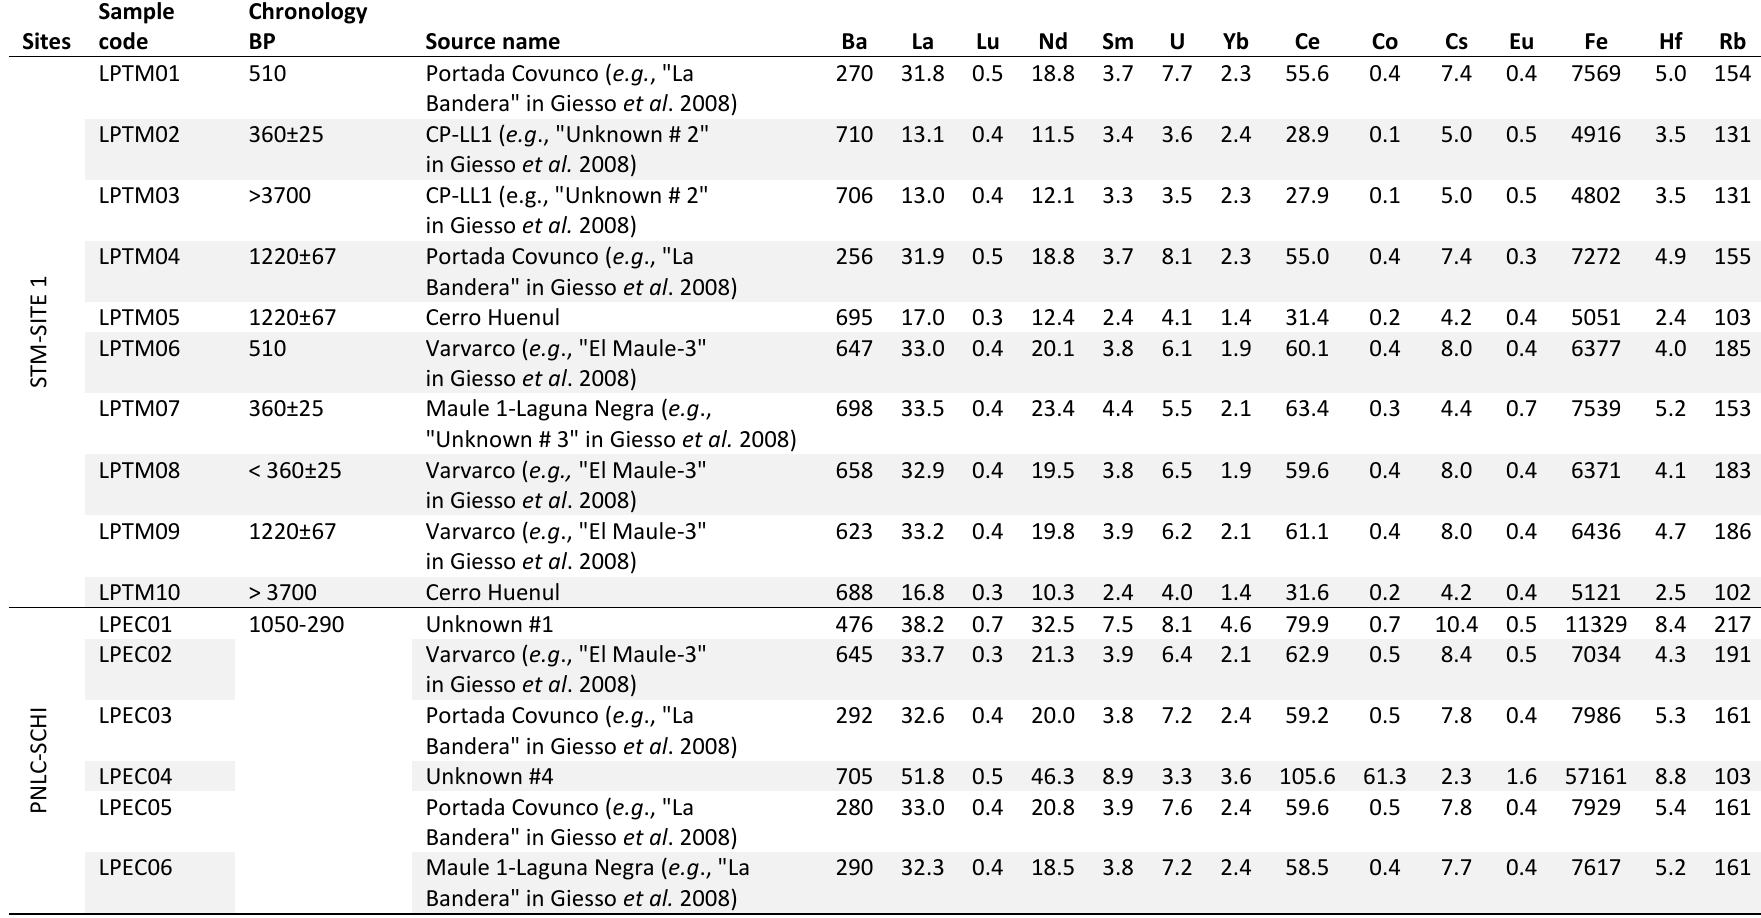
Table 1. Results obtained from INNA, between 2004 and 2007. Update of the table published in Giesso et al. (2008). Sites